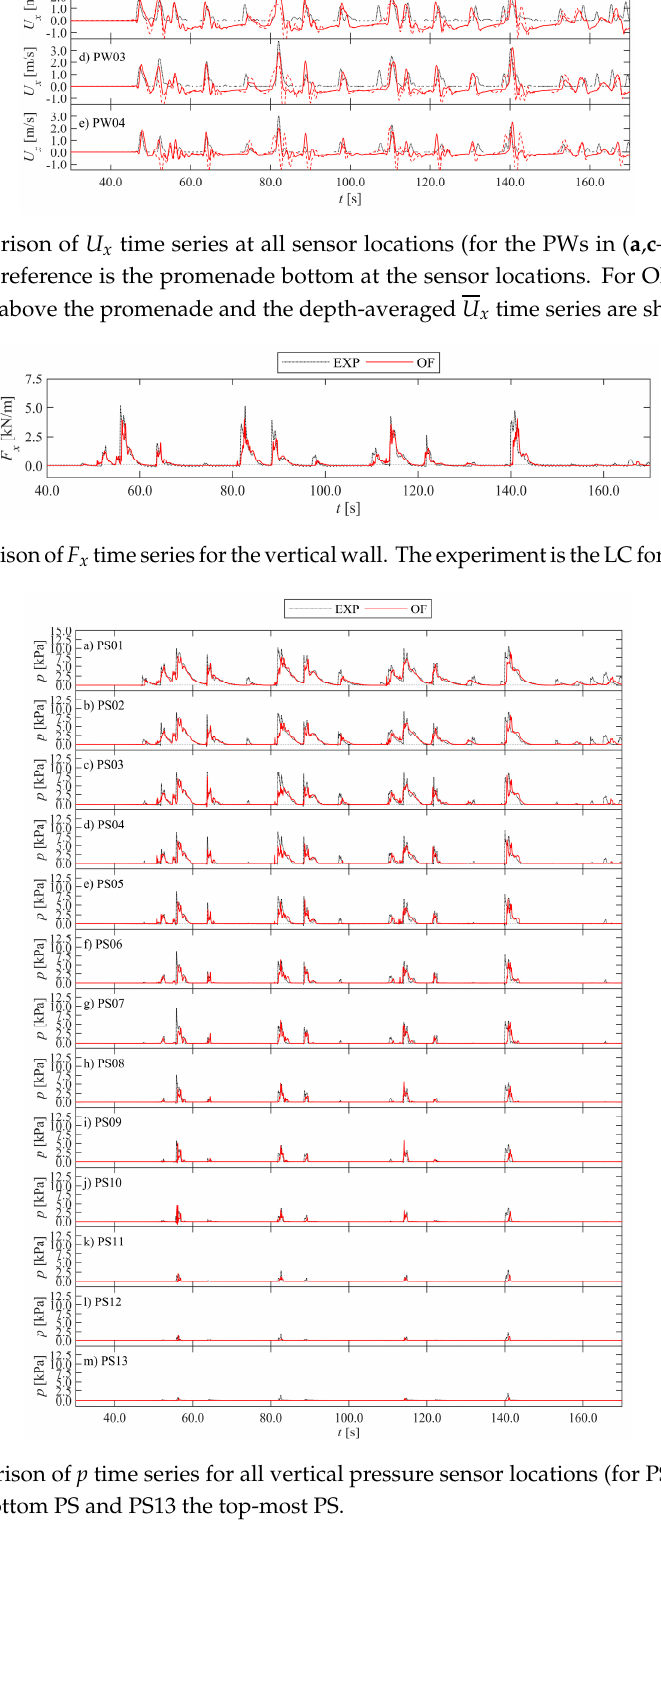
Figure 7. Comparison of p time series for all vertical pressure sensor locations (for PS01–13 in ( a–m )), PS01 being the bottom PS and PS13 the top-most PS.